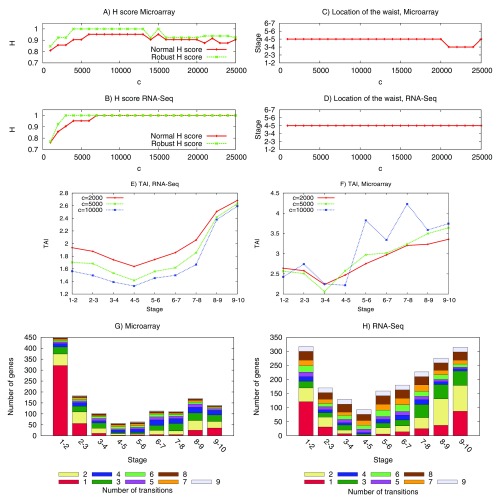

Drosophila results using absolute expression levels.Graphs (
a) and (
b) show the hourglass score (normal and robust) as a function of the transition threshold
c for the two datasets. Graphs (
c) and (
d) show the location of the hourglass waist (stage-pair) as a function of the transition threshold
c for the two datasets. Graphs (
e) and (
f) show the Transcriptome Age Index of transitioning genes for three different values of
c (chosen so that the number of genes with known age index assigned to each stage is at least 10) for the two datasets. Graph shows the transitioning genes for the Microarray dataset with
c = 5000. The transitioning genes constitute 21% of all genes in that dataset. 62% of those genes transition in a single stage-pair. Of the remaining, 58% transition only in consecutive stage-pairs. Similarly, graph (
h) shows the transitioning genes for the RNA-Seq dataset with
c = 10000. The transitioning genes constitute 5% of all genes in that dataset. 45% of those genes transition in a single stage-pair. Of the remaining, 53% transition only in consecutive stage-pairs. [Dataset 11].